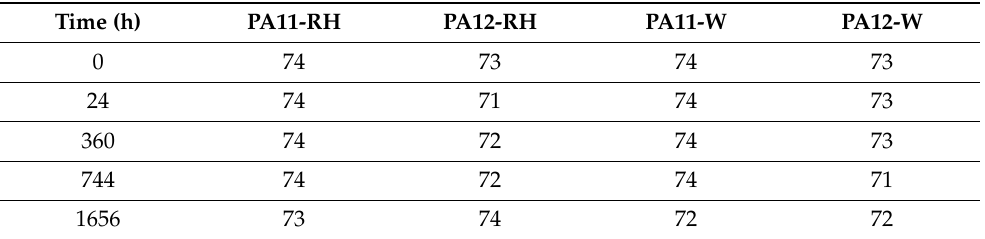
Table 7. Shore-D hardness values ( ± 2) for PA11 and PA12 at different aging